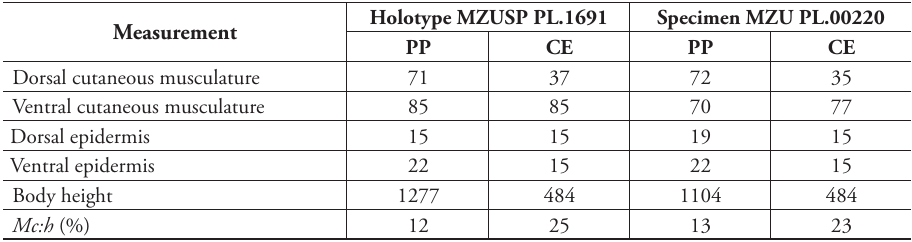
Table 4. Body height and cutaneous musculature in the median region of a transverse section of the pre-pharyngeal (PP) and cephalic (CE) regions, in micrometres, and ratio of the thickness of cutaneous musculature to the height of the body (mc:h index) of specimens of Cratera nigrimarginata sp. n. Holotype MZUSP PL.1691 Specimen MZU PL.00220 Measurement PP CE PP CE Dorsal cutaneous musculature 71 37 72 35 Ventral cutaneous musculature 85 85 70 77 Dorsal epidermis